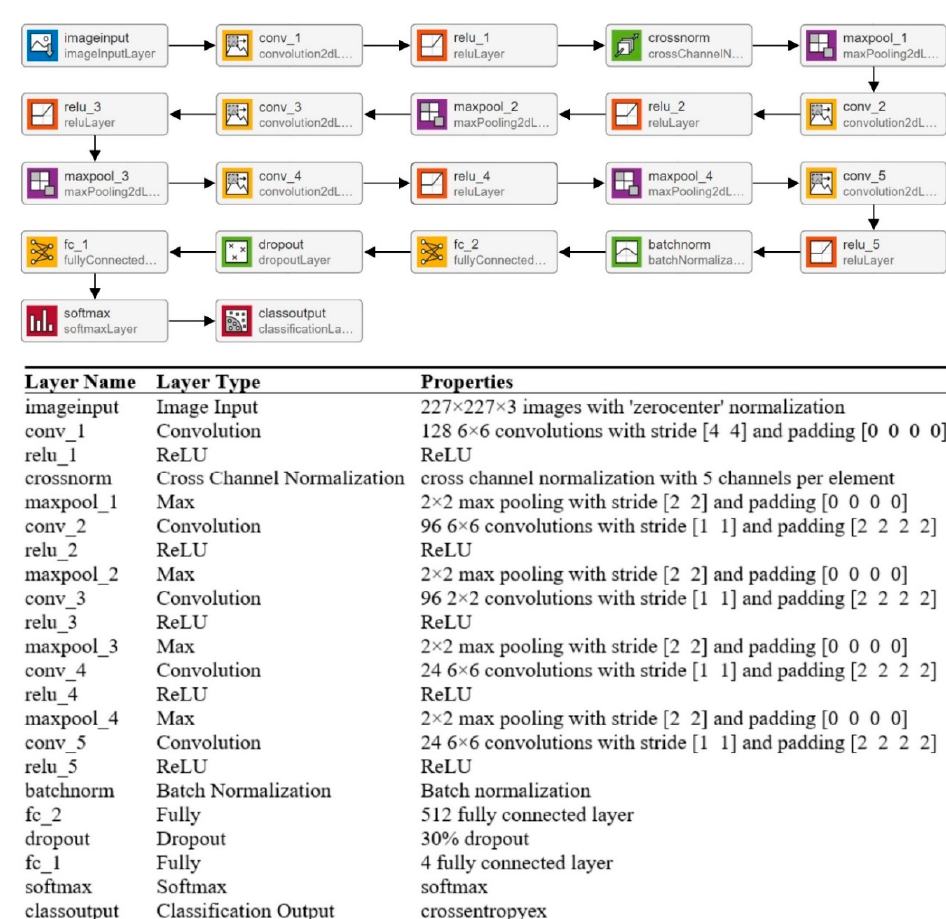
Figure 3. Complete description of the 22-layer CNN model.